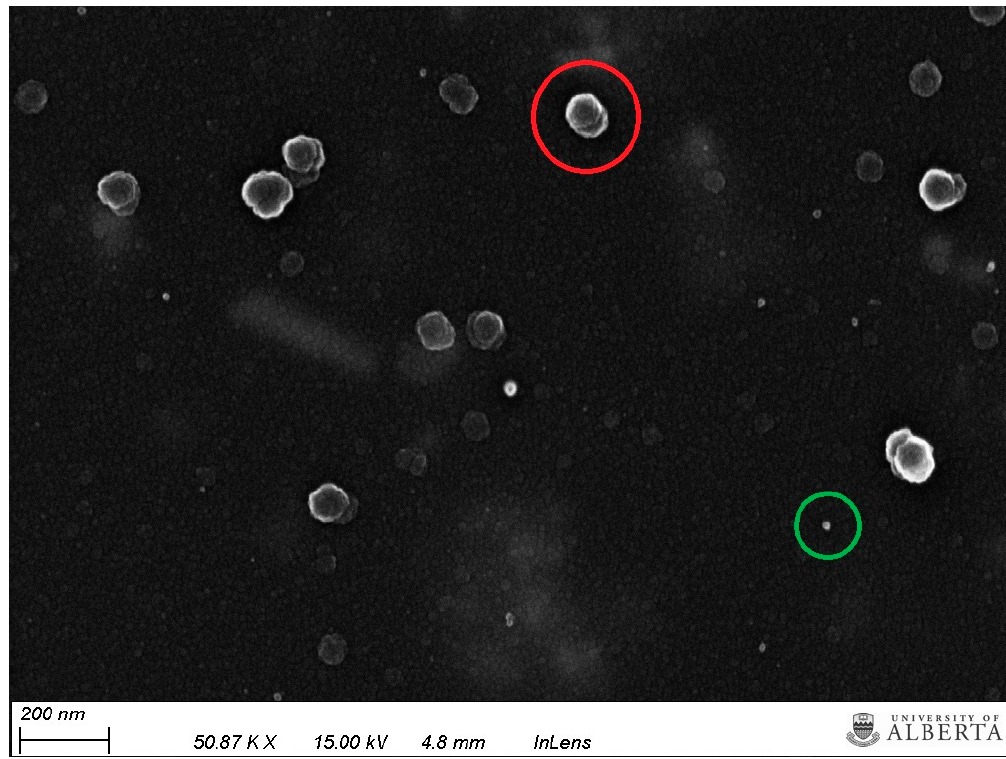
Figure 2. SEM secondary electron (SE) image of precipitates retained on carbon tape for X70 steel. An individual particle is circled in green while an agglomerate is circled in red.